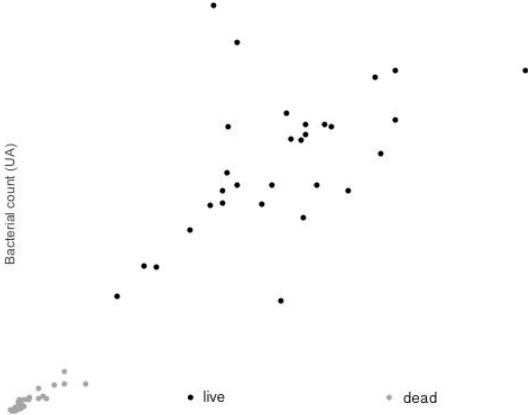
Figure 3. Scatter diagram of the percentage of area colonized by viable and non-viable bacteria as a function of bacterial counts on all